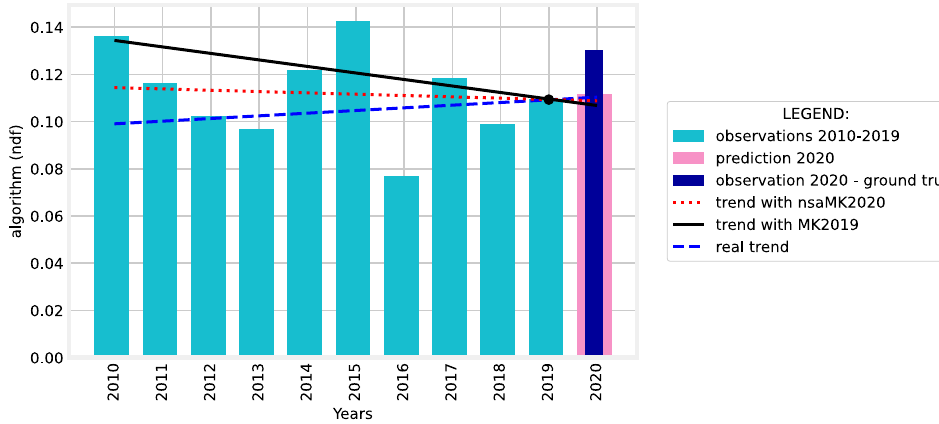
Figure 1. Trend evaluation comparison for the key term ’algorithm’.